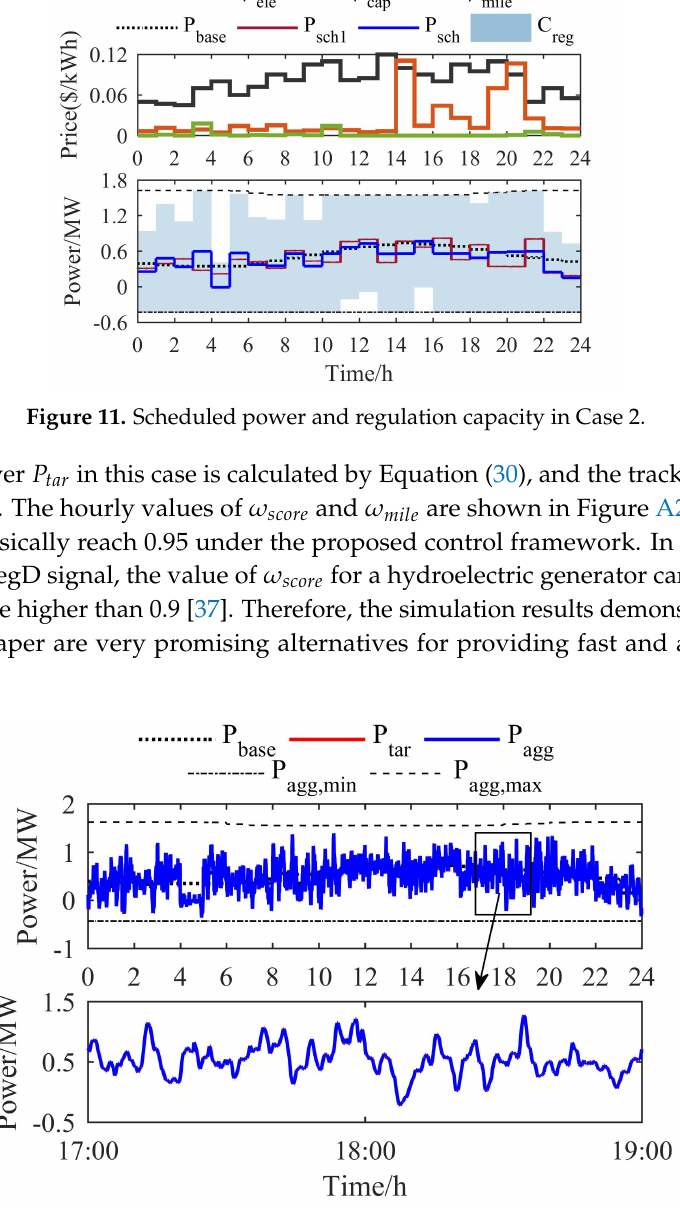
Figure 12. Tracking performance in Case